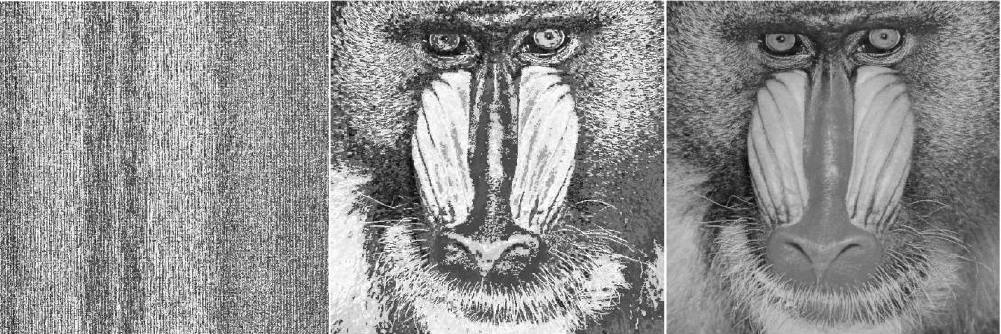
Figure 6. Decryption of Mandrill image. From left scrambled image, descrambled XORed image with configurations 𝐼′ = 𝑑(𝐸, 𝐿 0 , 𝑣 𝐶𝐺𝐿 , 𝑃𝐵𝐶, 12,7) , and original image (UnXORed image).